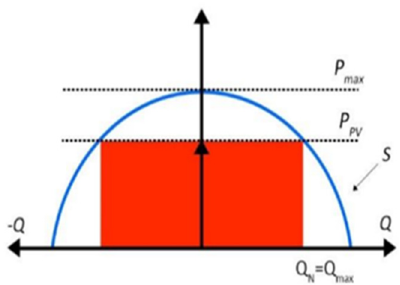
Figure 3. P-Q diagram of inverters [19].